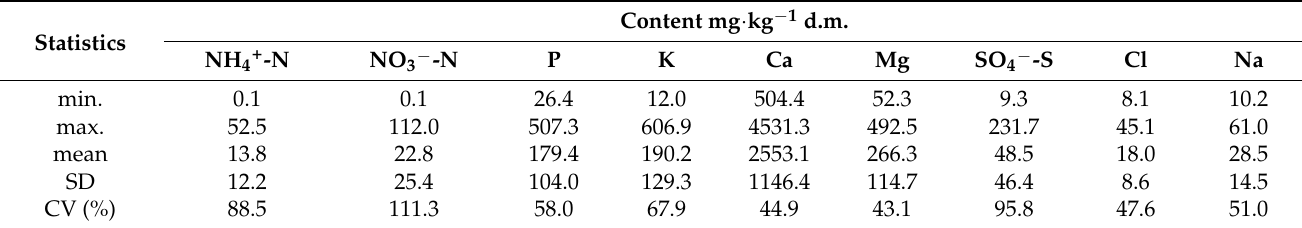
Table 6. The content of macronutrients, chloride, and sodium in soils of six allotment gardens in Gorz ó w Wielkopolski. AGs